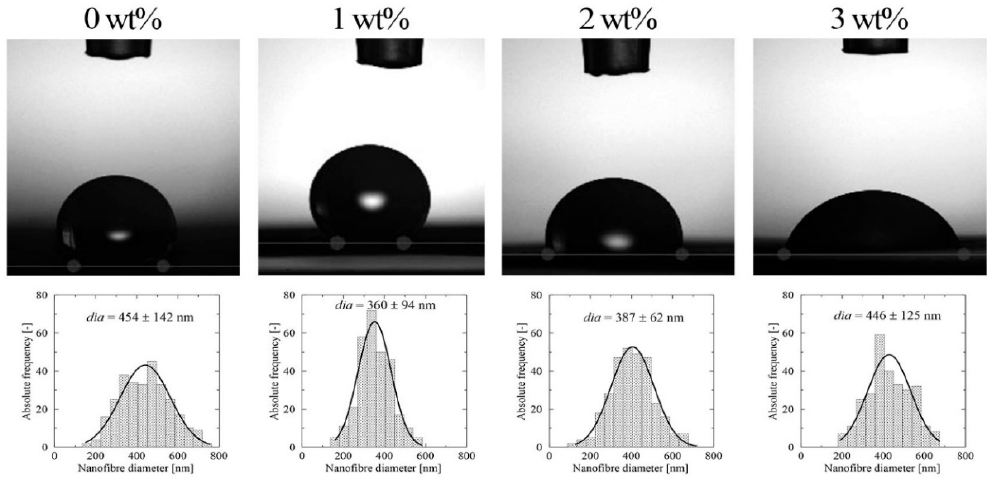
Figure 8. Fiber distribution and wettability of the neat 10 wt% PVB and 10 wt% PVB with MAG 10 membranes.